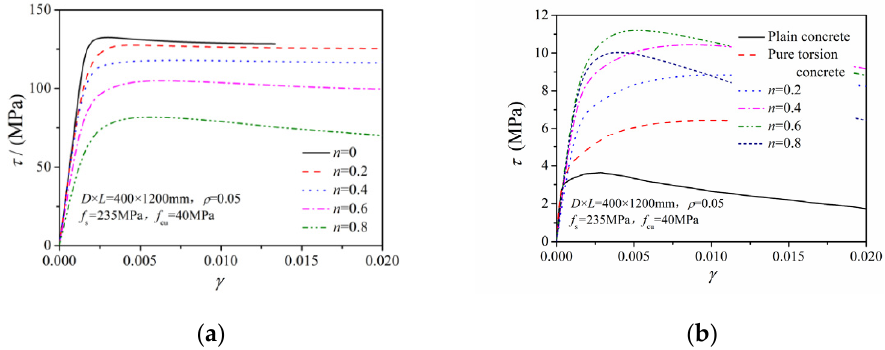
Figure 8. τ – γ relation of the steel tube and concrete under different axial compression ratios: ( a ) Steel tube; ( b ) core concrete.